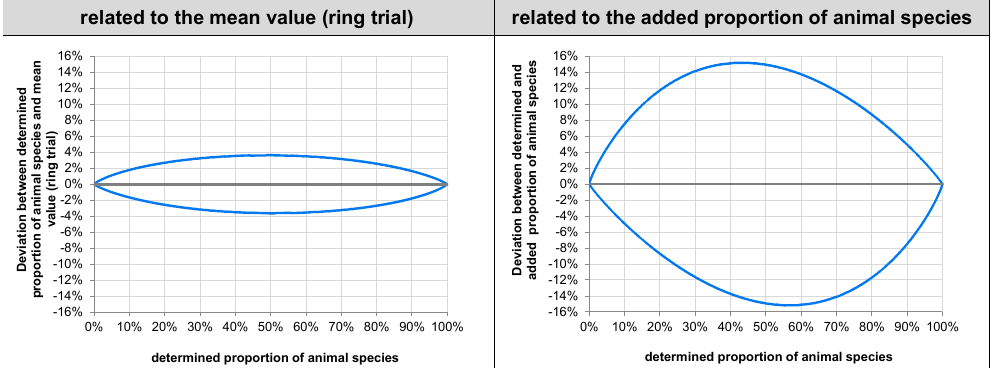
Figure 4. 95% measuring uncertainty interval for the proportion of the animal species determined, based on a single measurement, independent of the animal species. For a 50% proportion of the animal species, the “true value” can be 3.6% (percentage points) lower or higher, if the bias is not taken into account, or even 15.2%, if the bias is taken into consideration. z scores were calculated for interlaboratory evaluation across samples and animal species (Figure 5). z scores measure standardized deviations of laboratory mean values from the overall mean value. An absolute z score > 2 hints at a statistically significant deviation of the respective laboratory.